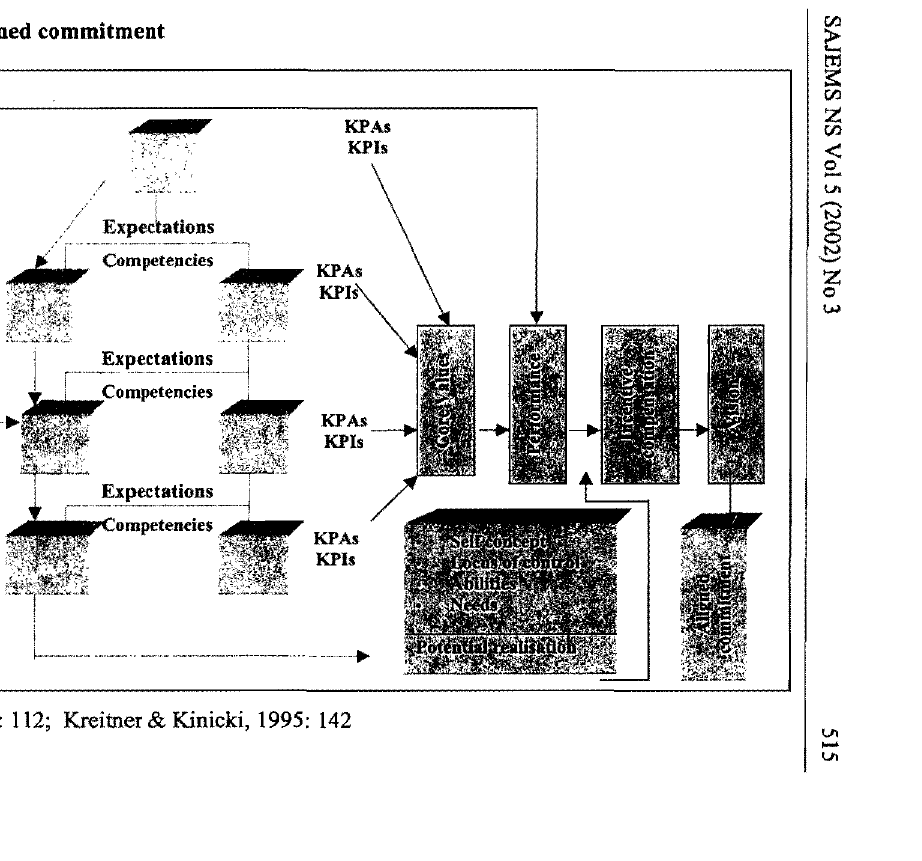
Figure 1 High performance and aligned